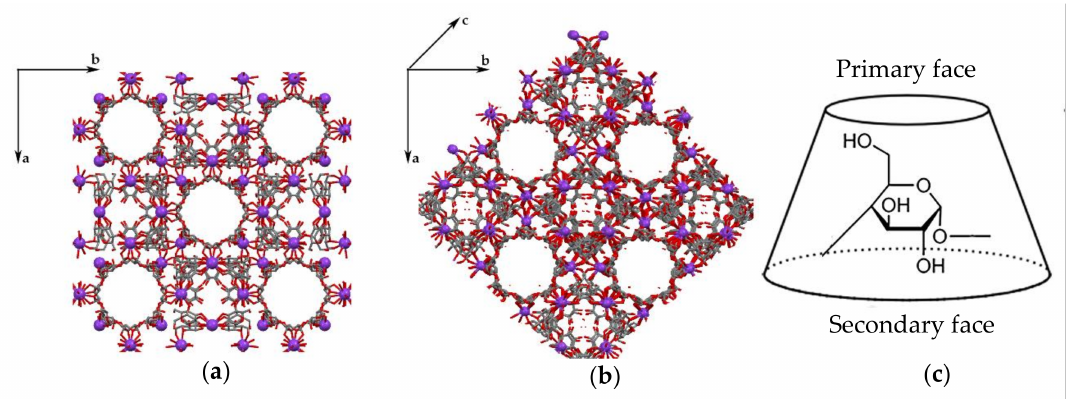
Figure 1. Crystal structure of ( a ) α - and ( b ) β -phase of γ -CD-MOF-1 (crystal structures were redrawn from the Cambridge Crystallographic Data Centre (CCDC) deposits LAJLAL [11] and LAJLAL2 [12]); ( c ) representation of 3D structure of γ